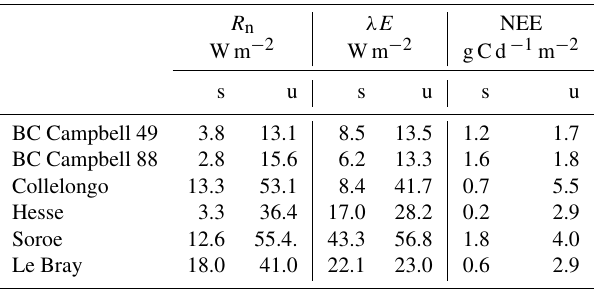
Table 6. Statistics of the model evaluation with daily flux values at six sites: systematic and random